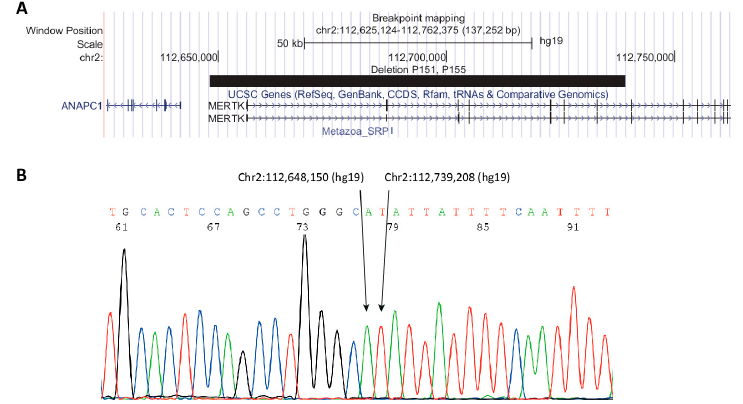
Figure 3. Breakpoint mapping of deletion in P151 and P155. ( A ) UCSC (University of California Santa Cruz) browser track showing deletion as a black bar. ( B ) Sanger sequencing showing the sequence surrounding the breakpoint.